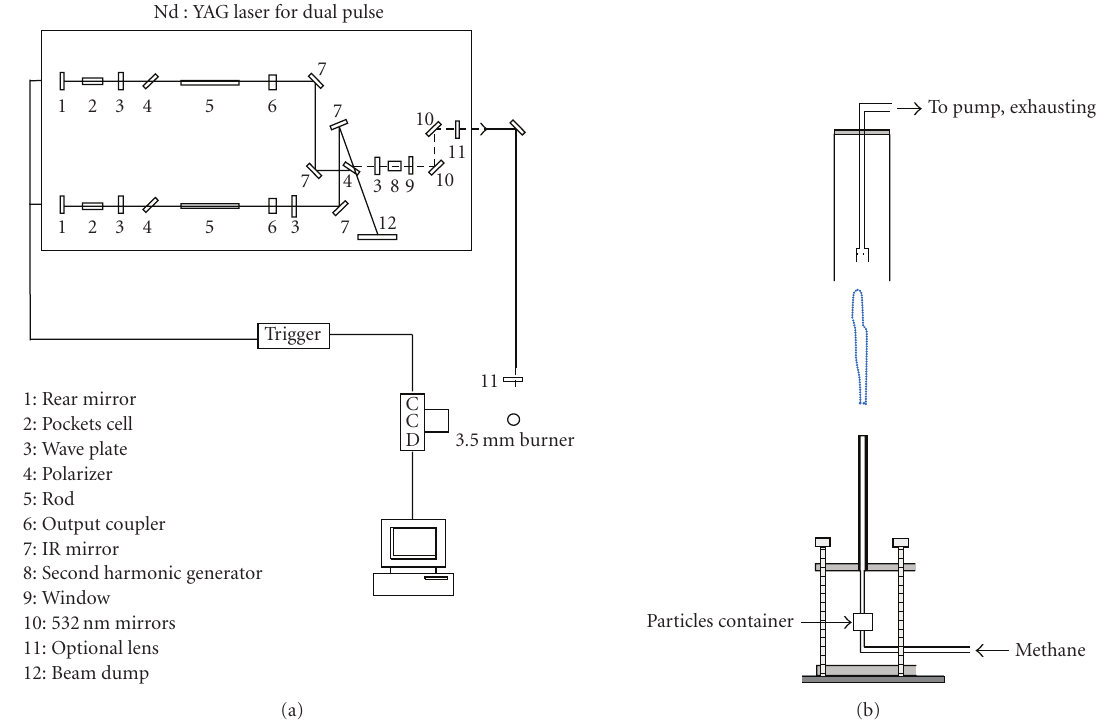
Figure 1: (a) Schematic of PIV experimental arrangement. (b) Schematic of